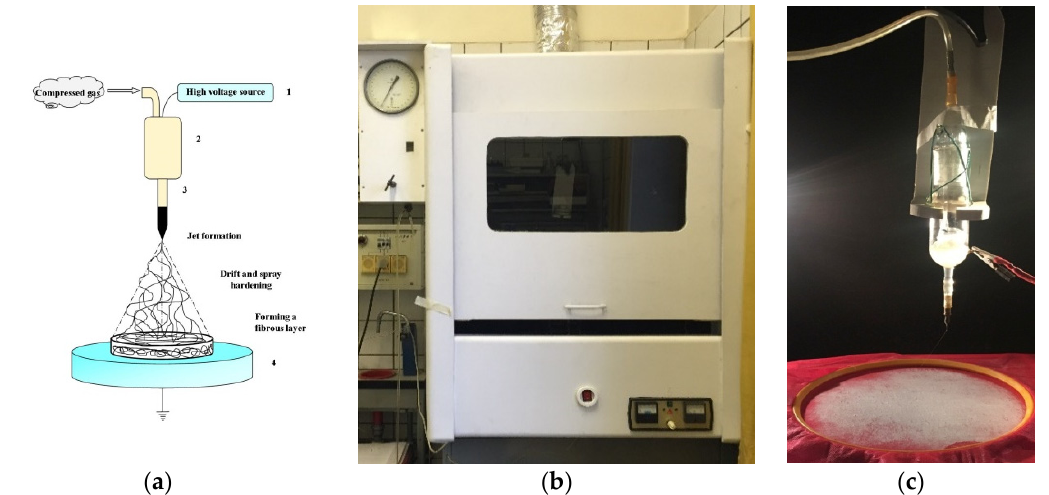
Figure 2. Schematic illustration showing the electrospinning process ( a ), general view of the experimental setup ( b ) and the process of obtaining ultrafibrous material based on PLA ( c ).